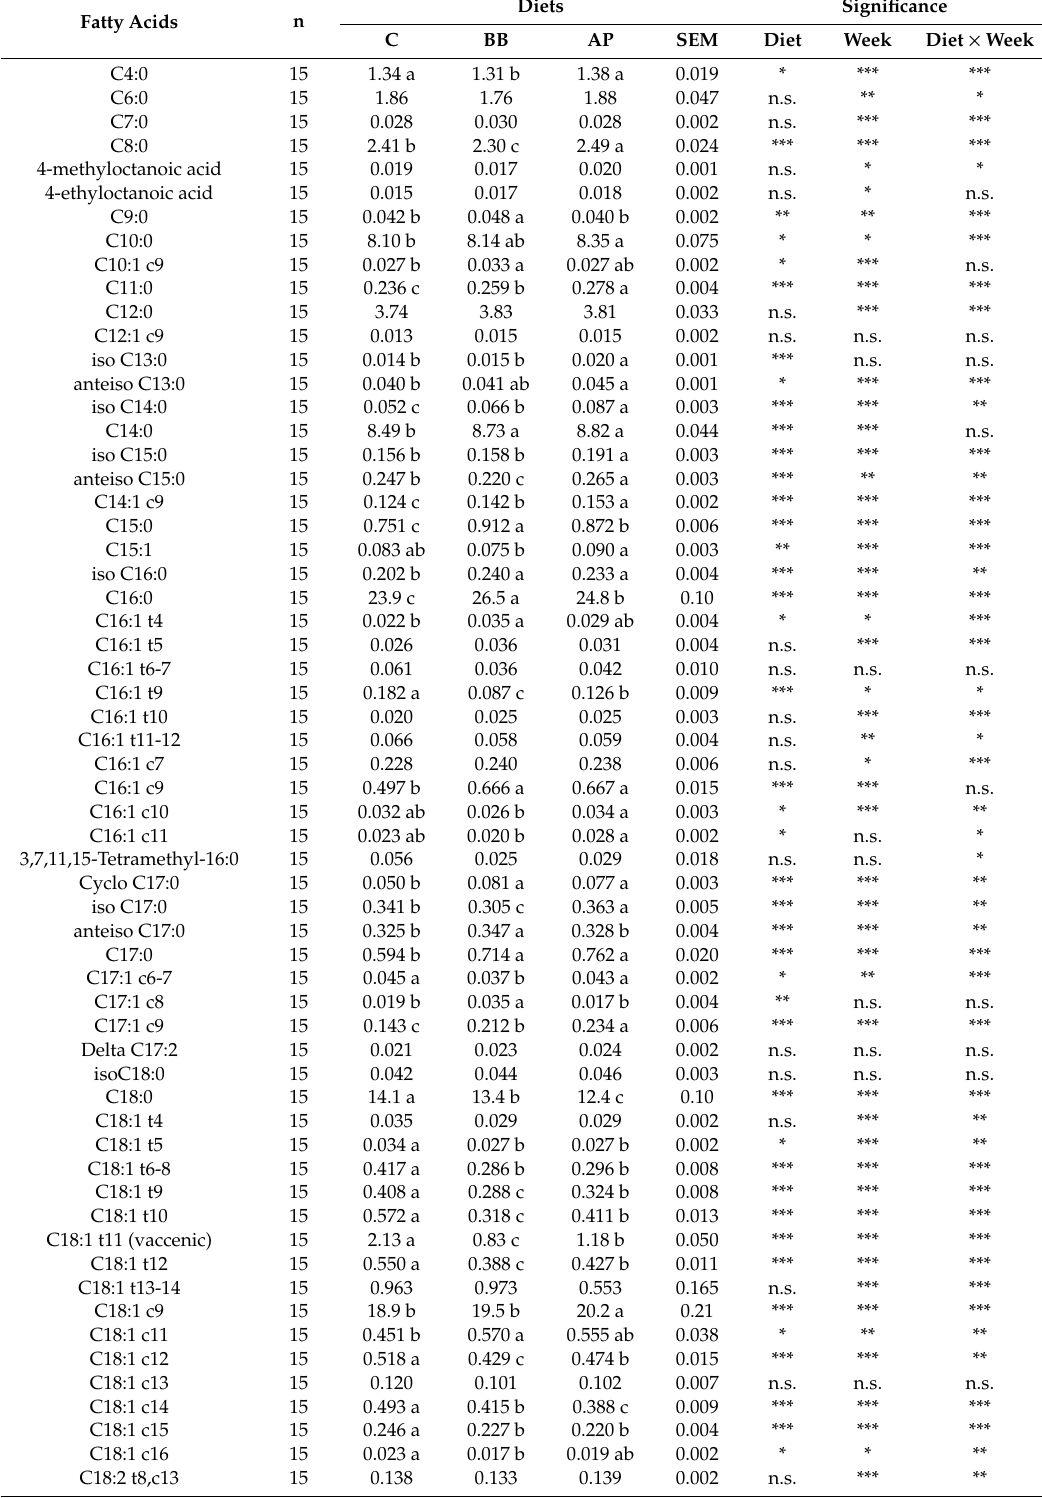
Table 5. Comparison of fatty acid composition (g / 100 g total fatty acids) measured in goat milk from refrigerated tank according to the e ff ects considered from 7th to 27th lactation week. Fatty